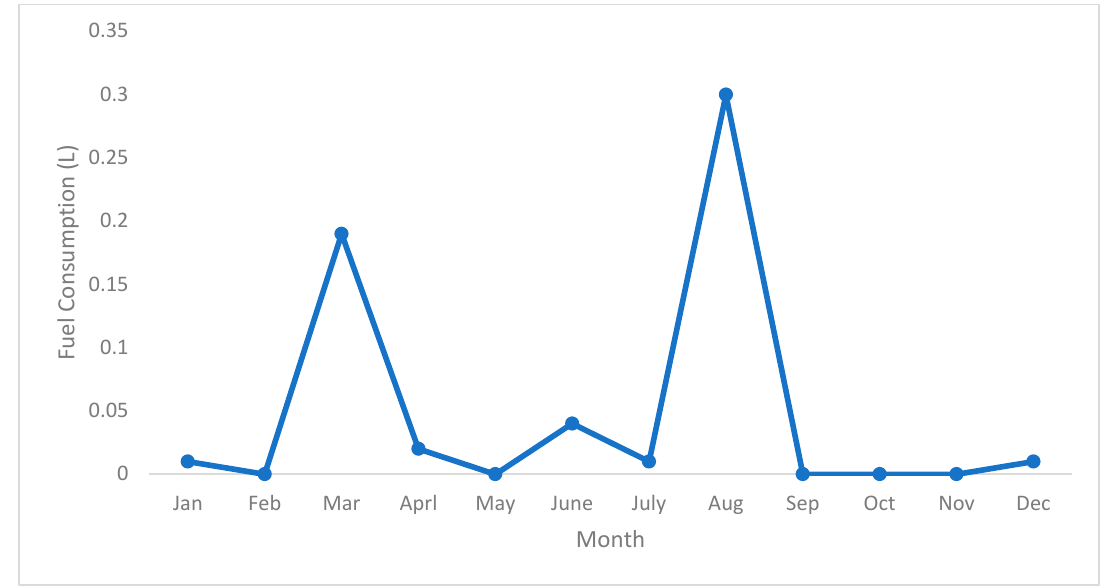
Figure 8. Monthly genset power output (KW).